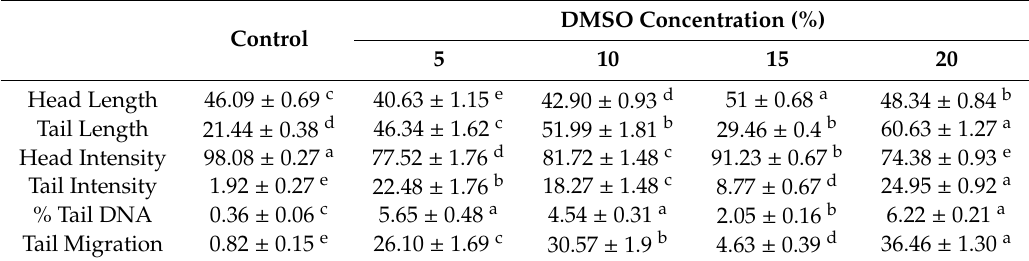
Figure 6. Correlation between MSR and survival rate to percentage of Tail DNA (x) in frozen–thawed sperm: ( a ) relationships between MSR and % Tail DNA; ( b ) relationships between survival rate and % Tail DNA. R 2 = Pearson’s correlation coefficient. 4. Discussion In this work, the highest frozen–thawed sperm motility was observed using 15% DMSO, which is an effective CPA used in spotted halibut sperm cryopreservation. This result is similar to Tian et al. (2008) [1], who found 13.3% DMSO or PG to be successful CPAs, as no substantial differences in motility were evaluated between fresh and frozen–thawed sperm. The most effective CPA for fish spermatozoa has been identified to be DMSO [27], mainly because of its small molecular structure, which allows it to easily enter and exit the sperm cell [28]. The DMSO provided good frozen–thawed sperm quality in starry flounder [29–31]. For some other flatfish species, DMSO has been considered to be reliable, including Brazilian flounder (10% DMSO), summer flounder (10% to 20% DMSO), and stone flounder (7.5% to 10% DMSO), but not for others including winter flounder and yellowtail flounder [5,27–29]. These findings suggest strong species-specificity of CPAs. By contrast, glycerol and EG produced less than 5% motility after cryopreservation in this study. Under the same conditions, Tian et al. (2008) [1] used glycerol and EG and found that they produced low post-thaw